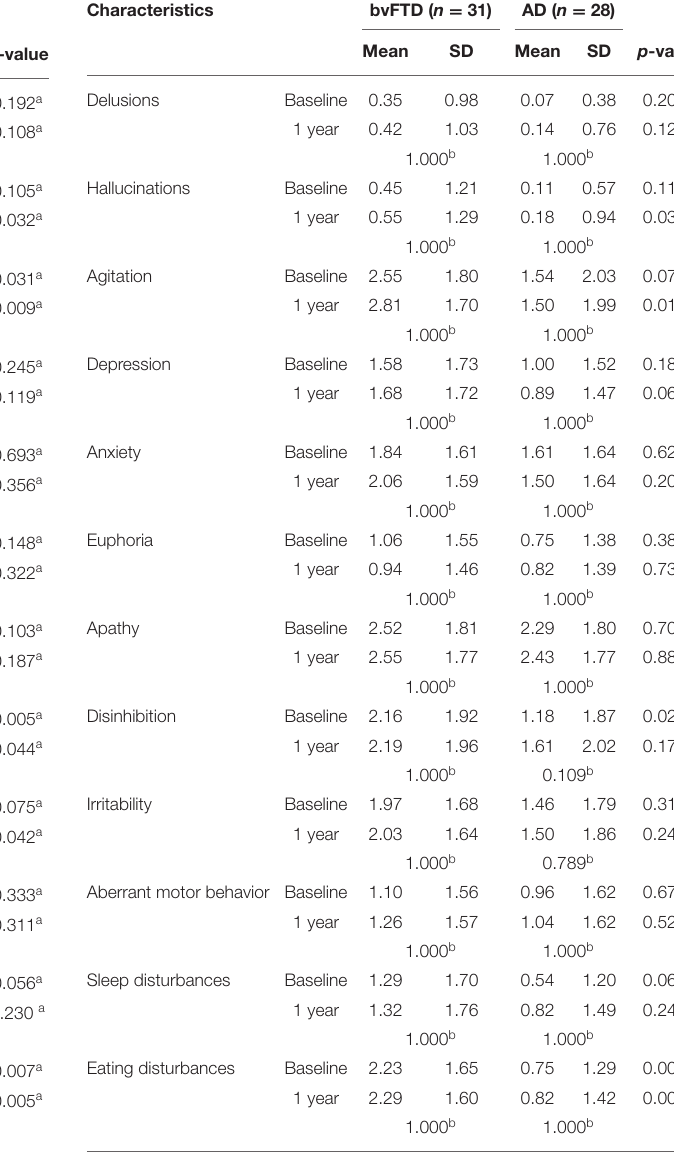
TABLE 2 | Mean neuropsychiatric inventory scores reported by caregivers for each symptom. Characteristics